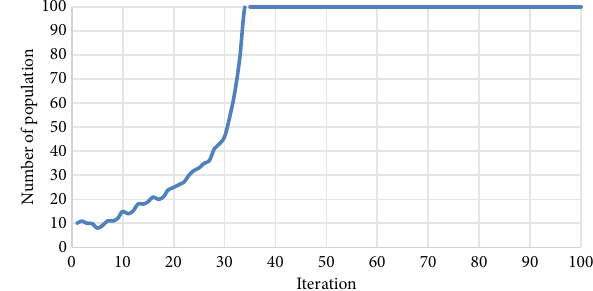
Fig. 13. The population number in the first front of the second model